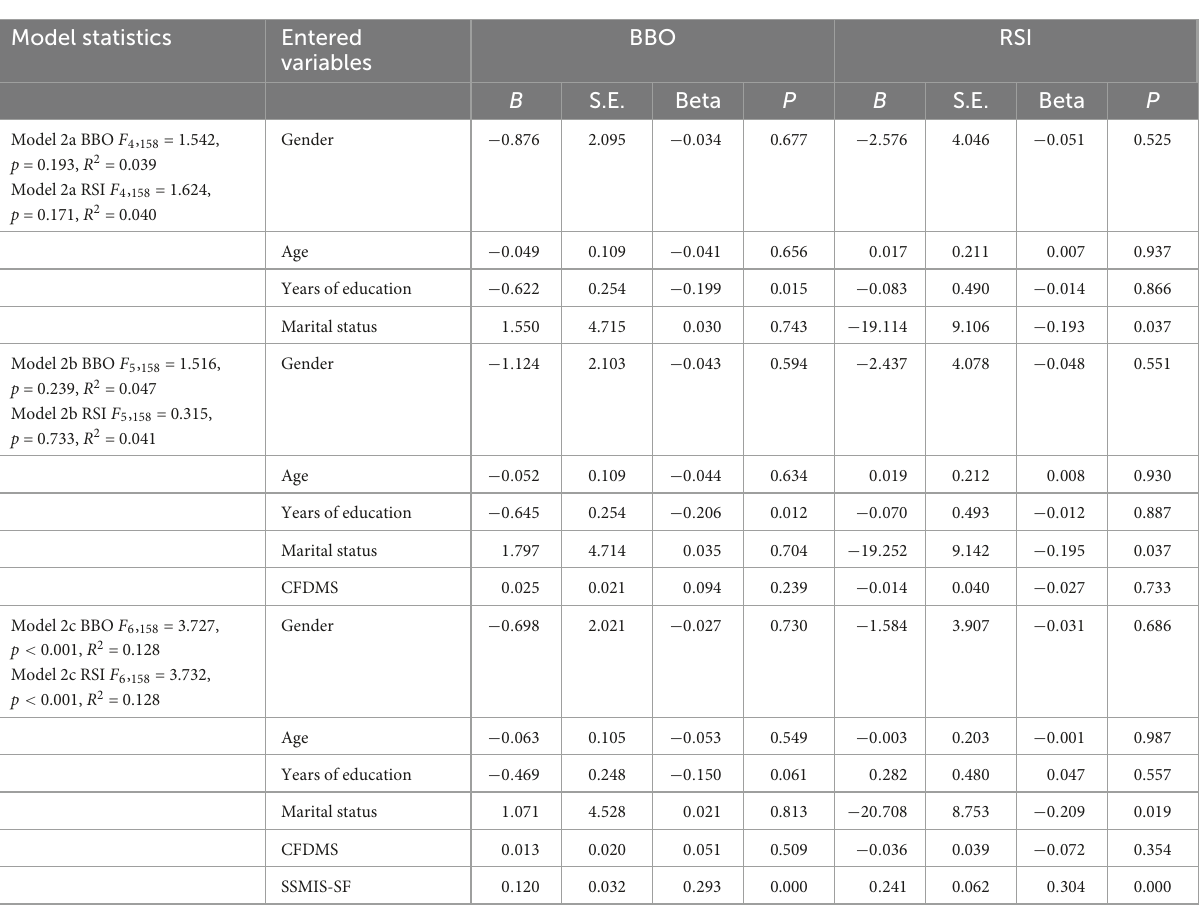
TABLE 3 Predictors of BBO and RSI for family members. Model statistics Entered